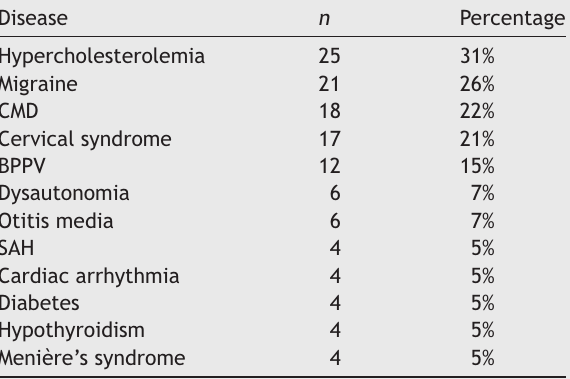
Comorbidities associated to persistent perceptual and postural dizziness no lugar de chronic subjetive dizziness in the study